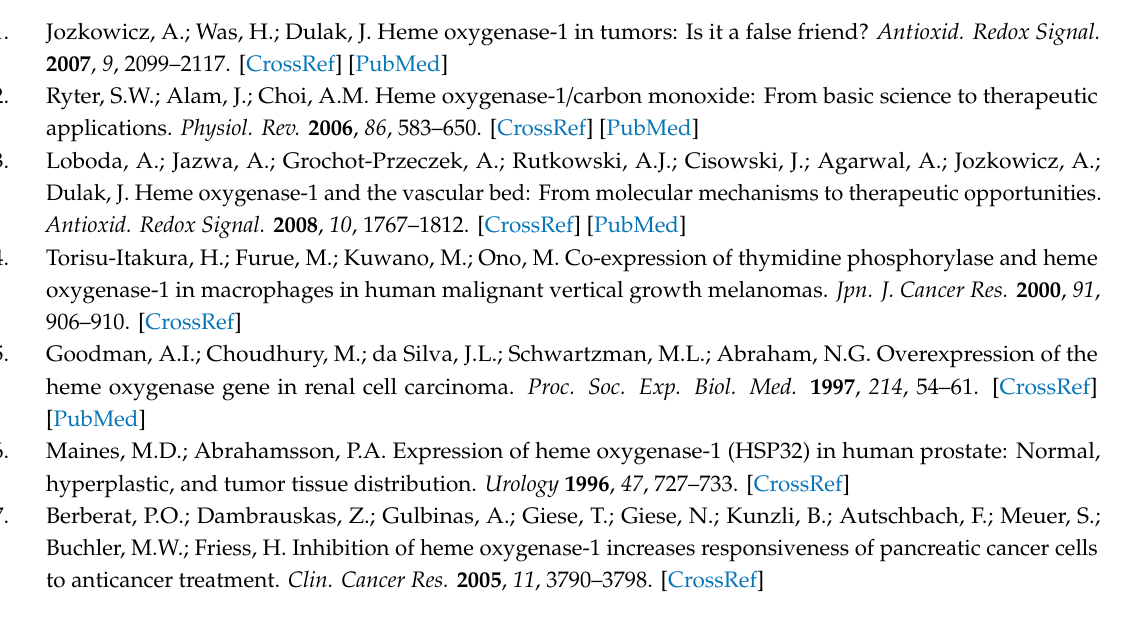
Figure S1. E ff ect of HO-1 expression in mice on primary tumor growth. Tumor volume in males (m) ( N = 4–10) ( A ) and females (f) ( N = 4–10) ( B ) of di ff erent HO-1 genotype: +/+ , +/ − or − / − . Each point represents mean ±